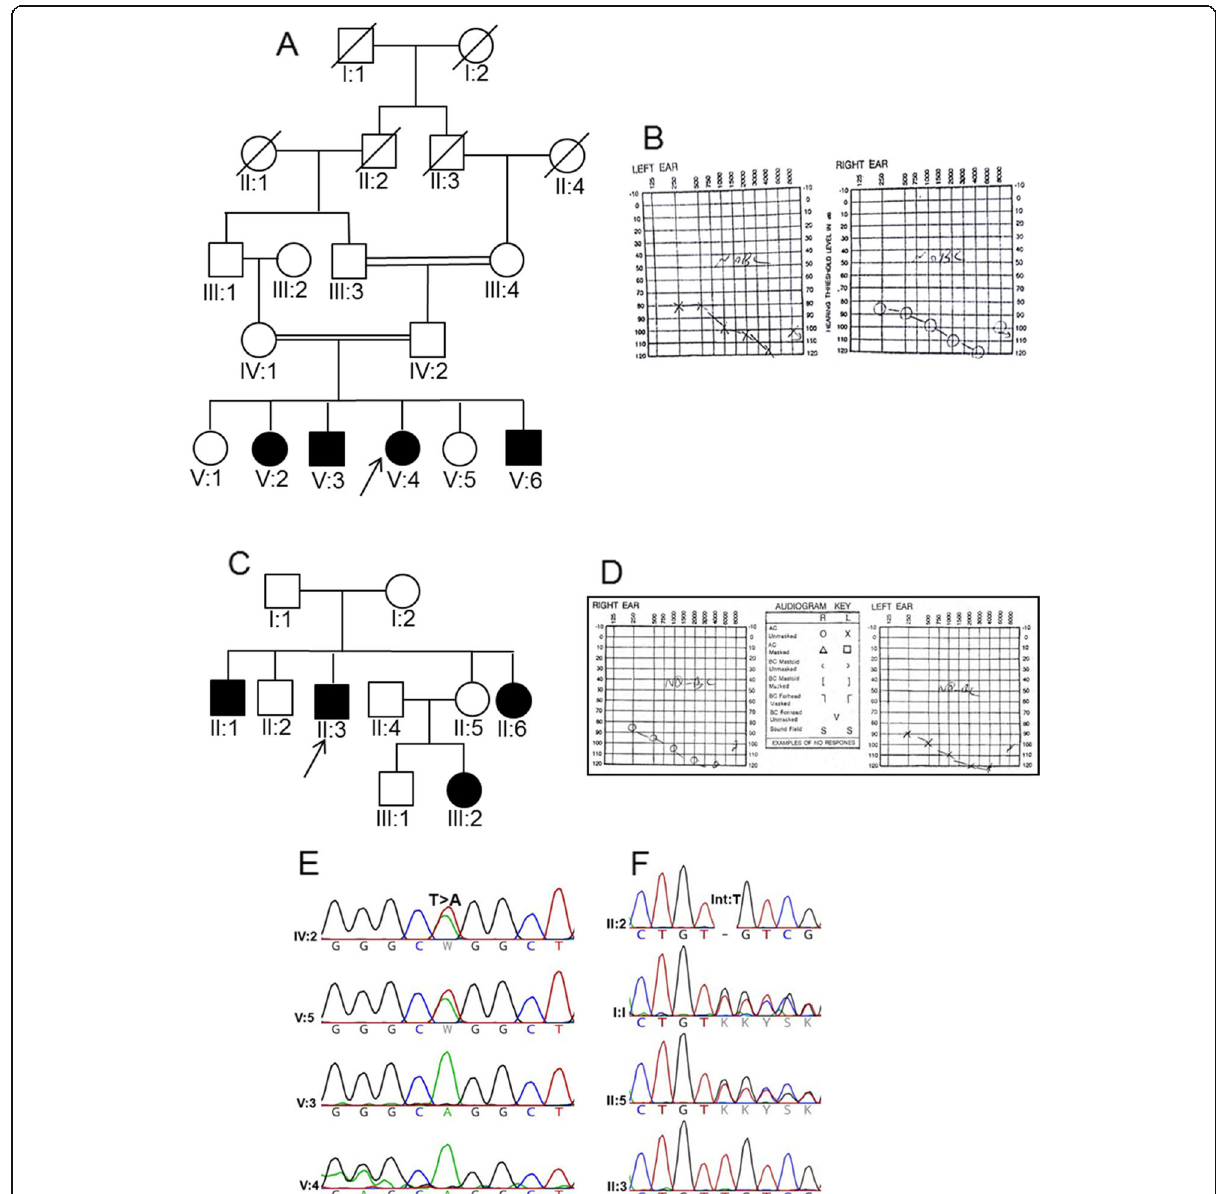
Fig. 1 Pedigrees and the proband audiograms, as well as sequencing chromatograms. a Pedigree of family 1 having autosomal recessive form of NSHL disease is drawn. The proband (V: 4), for whom whole exome Sequencing has been carried out is indicated by arrow. b Audiogram for pure tone audiometry (PTA) of the proband (V: 4) with profound hearing loss in both ears. c Three-generation pedigree of family 2 having autosomal recessive form of NSHL disease is drawn. The proband (II: 3), for whom whole exome Sequencing has been carried out is indicated by arrow . d Audiogram for pure tone audiometry (PTA) of left and right ears of the affected proband (II: 3) showed profound hearing loss. Hearing impaired individuals are illustrated by black-filled symbols. e Partial sequence chromatograms of MYO15A gene from two unaffected (IV.2 and V.5) and affected individuals (V: 3 and V: 4) in family 1 illustrate T to A transition at position 6442. f Partial sequence chromatograms of MYO15A gene containing (c.10504dupT:p.C3502Lfs*15) variant in proband (II: 3), his father (I: 1) and his siblings (II: 2 and II:5) in family 2 illustrates insertion of T as